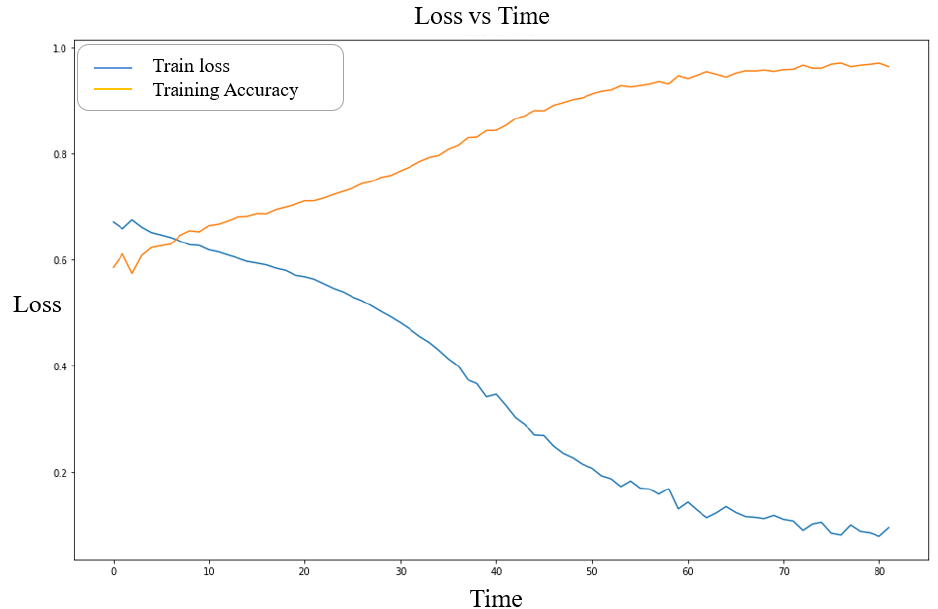
Figure 4. Loss and accuracy of the LSTM